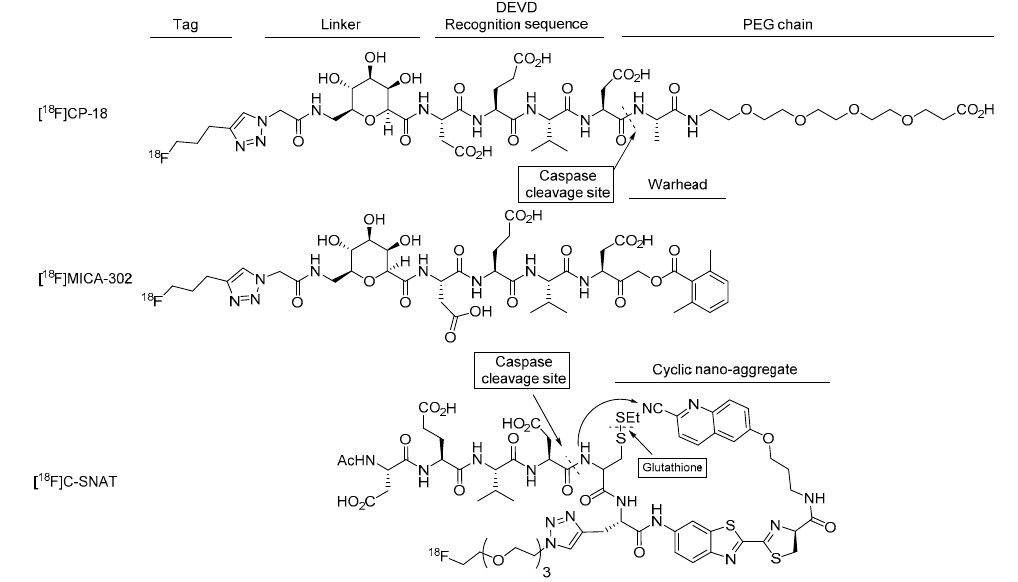
Figure 7. Molecular structure of DEVD-based radiotracers: [ 18 F]MICA-302 ABP, [ 18 F]CP-18 SBP and [ 18 F]C-SNAT SBP.